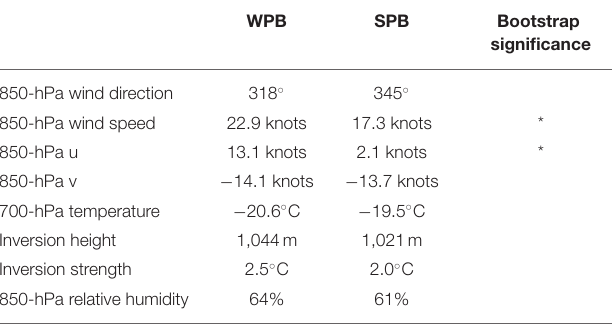
TABLE 4 | Mean sounding variables per-lake band morphology.